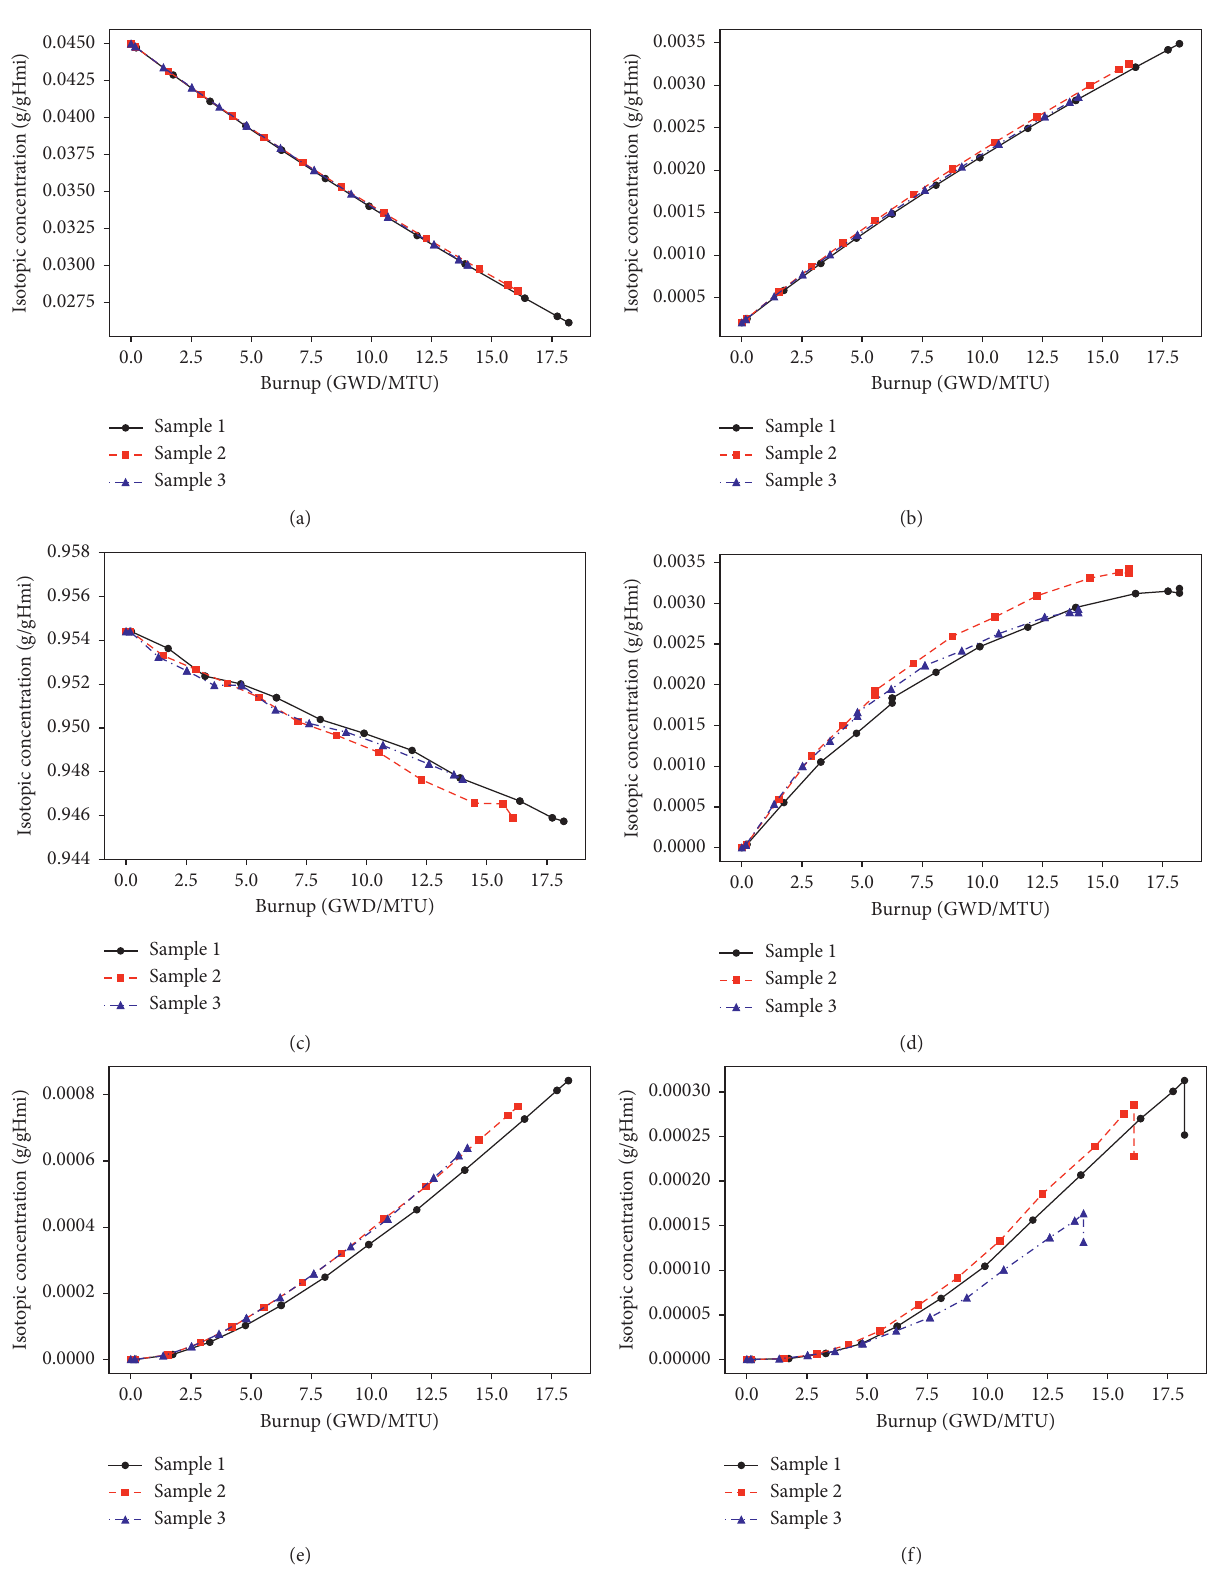
Figure 9: Variation of isotopic concentrations of six major actinides with burnup for the 2F2D1/F6 rod. Note: g/gHmi means that the isotope mass (g) is normalized to the grams of heavy metal observed initially in the region at the beginning of cycle. (a) U-235. (b) U-236. (c) U-238. (d) Pu-239. (e) Pu-240. (f)